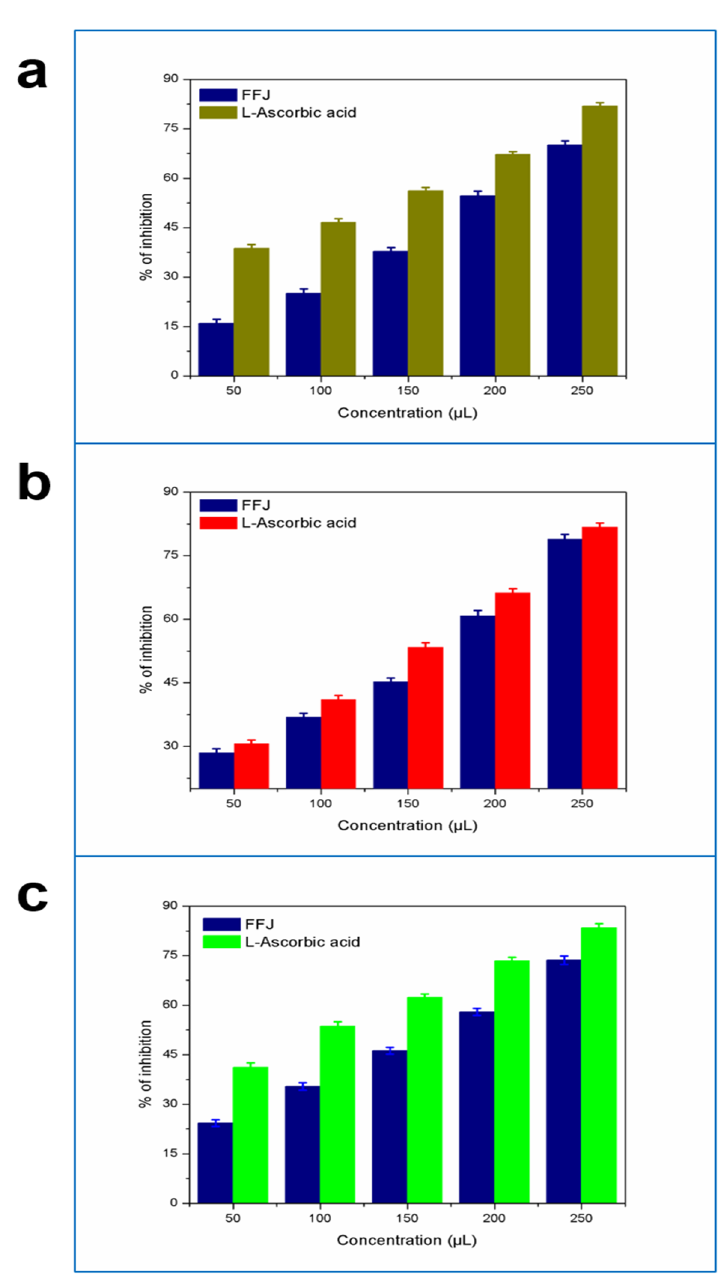
Figure 3. Antioxidant activities evaluated for the formulated avocado fruit juice using the DPPH ( a ) , ABTS ( b ) , and FRAP ( c ) assays.